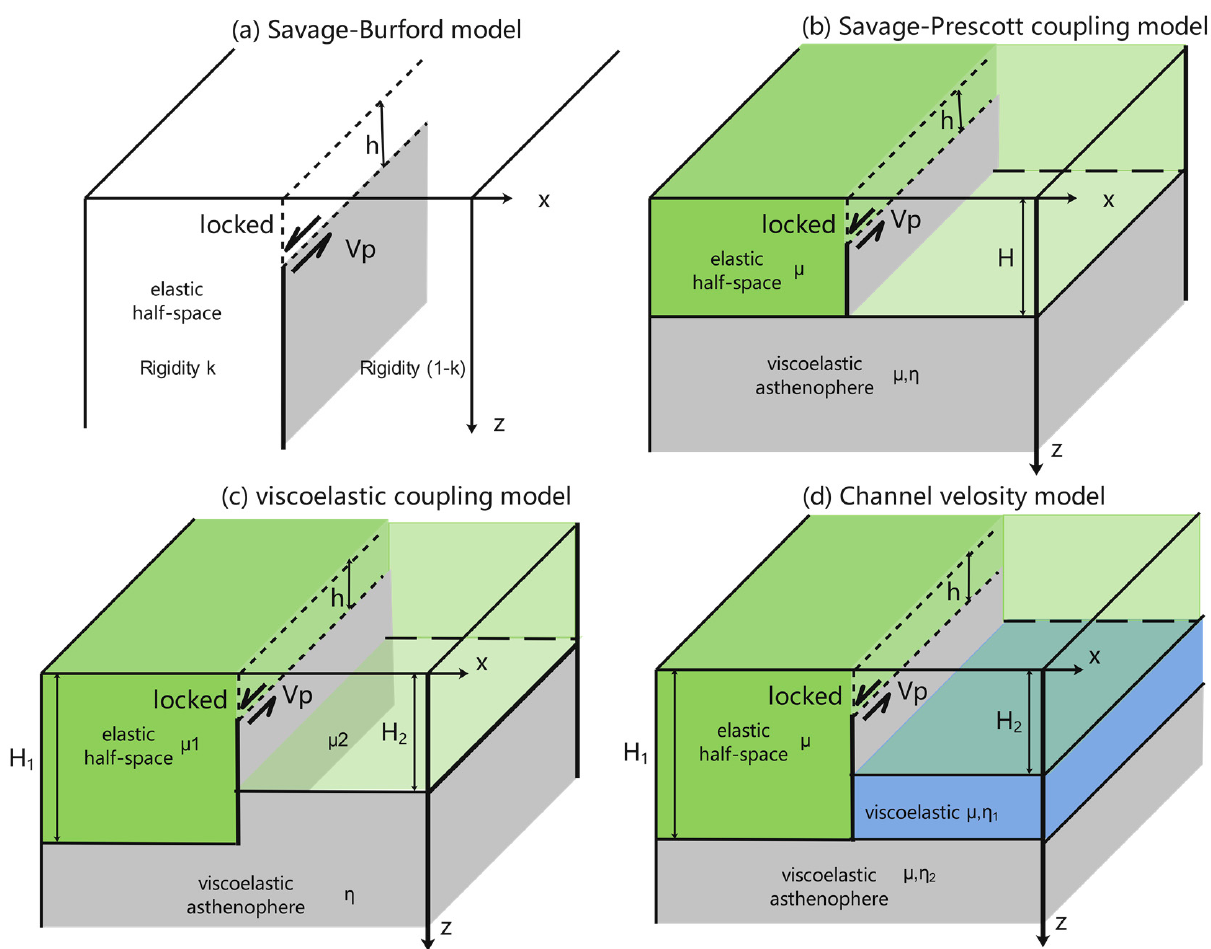
discussed in Section 4.1.3.